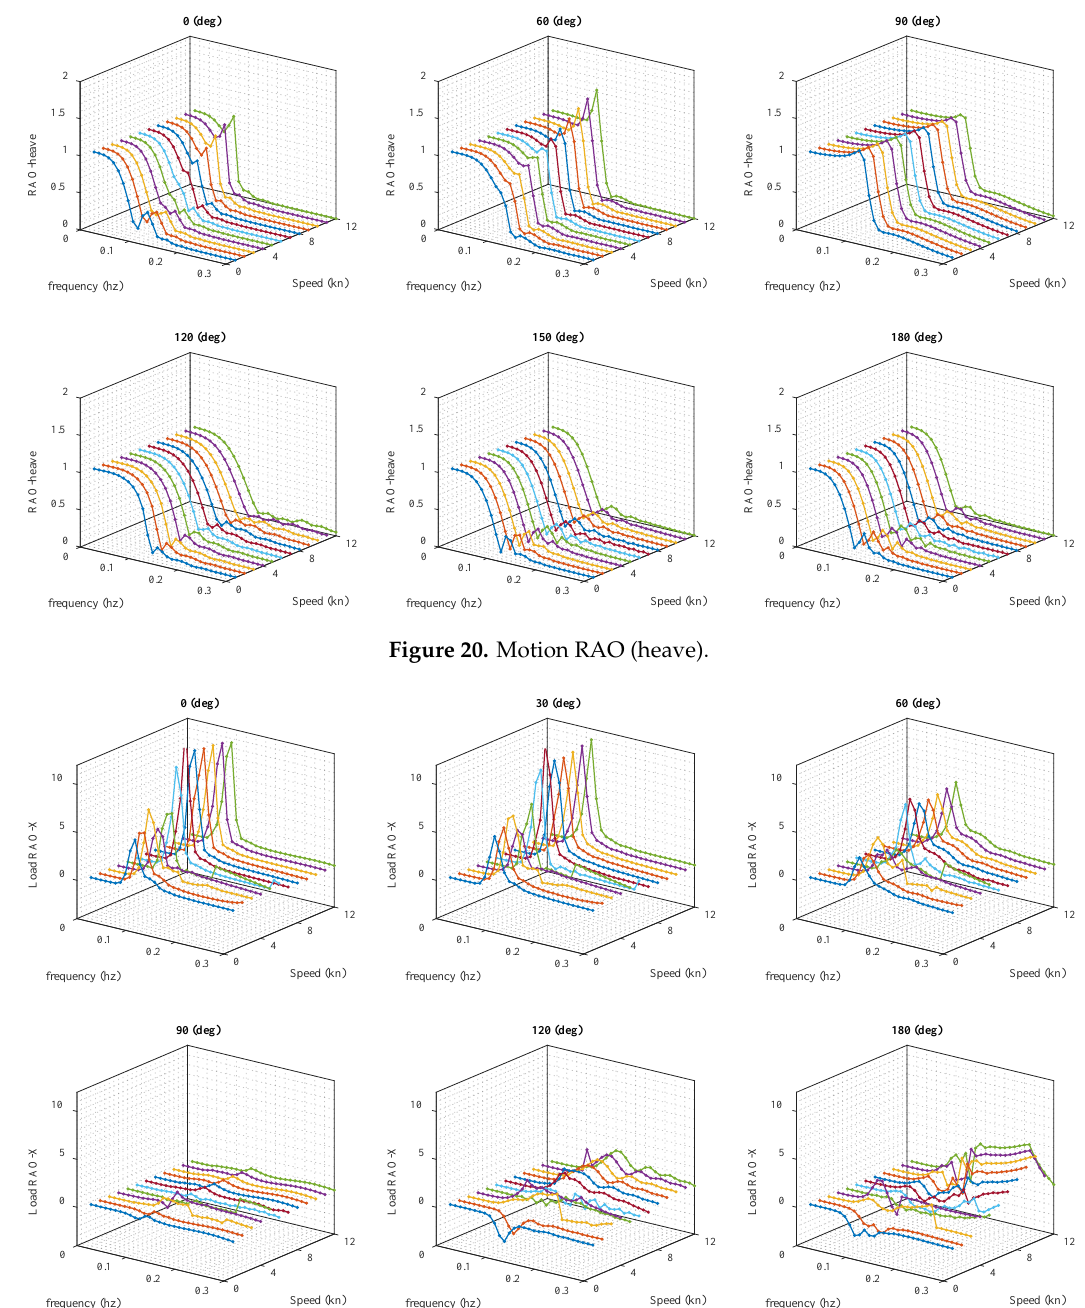
Figure 19. Damping coefficient (B 22 ).